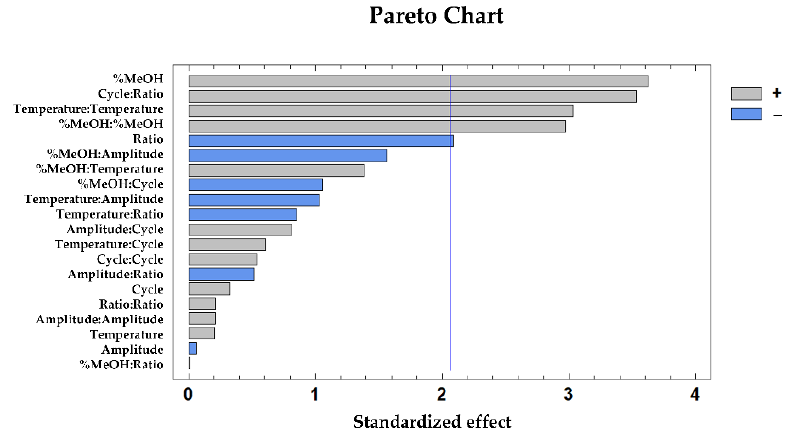
Figure 3. Pareto chart based on the BBD–RSM design representing the extraction of total phenolic compounds from mushroom samples.